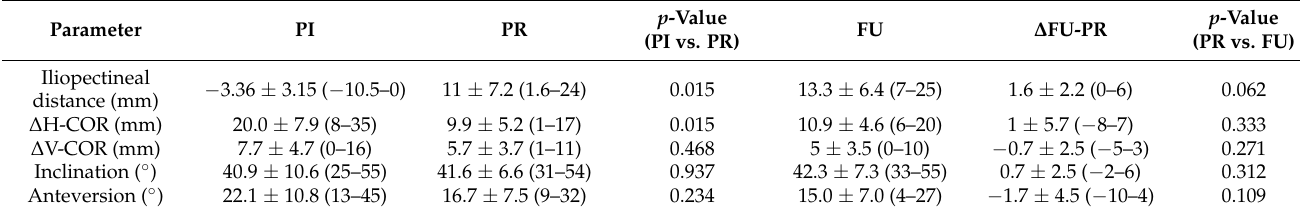
Table 3. Radiographic parameters and